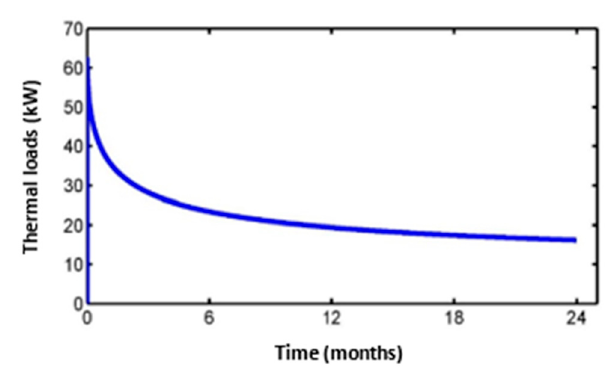
Figure 2. Thermal loads